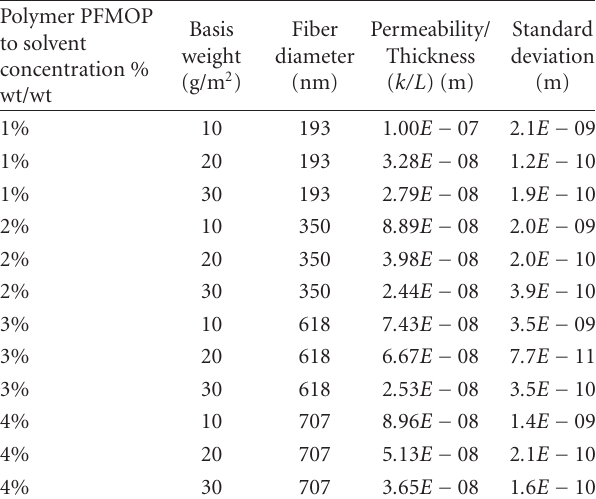
Table 3: Permeability